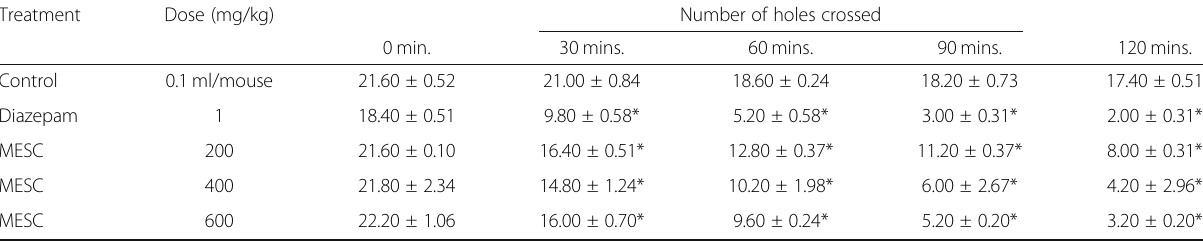
Table 3 The sedative effect of MESC on hole cross test in mice Treatment Dose (mg/kg) Number of holes